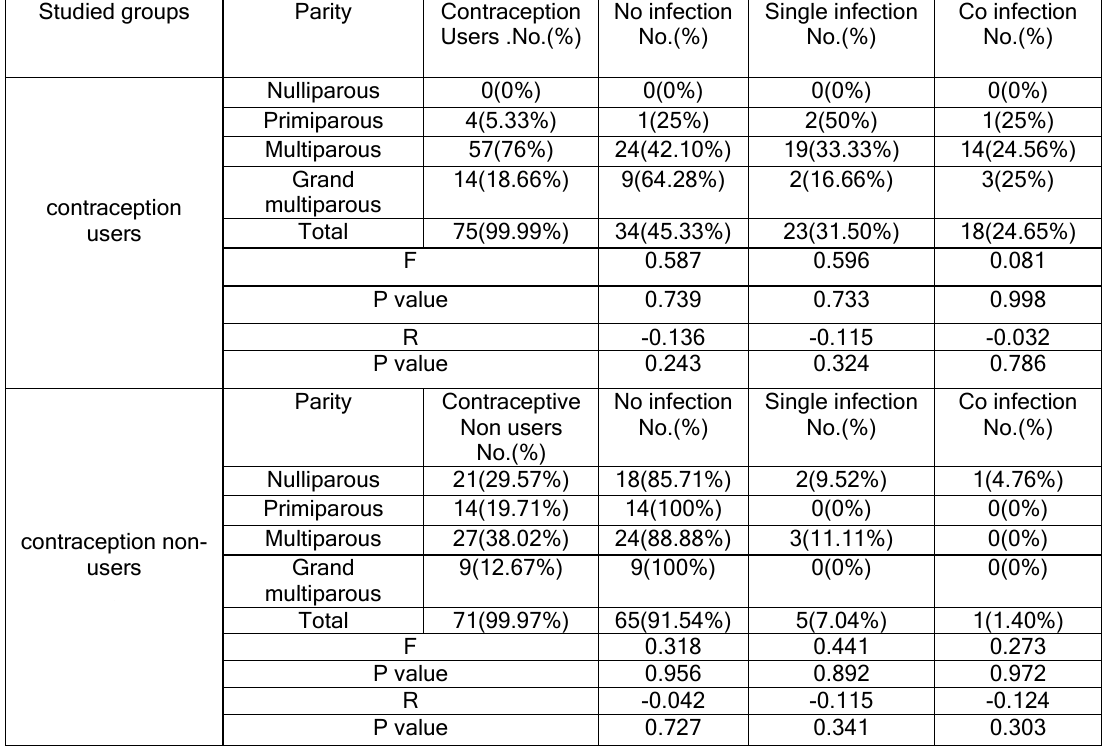
t-Test for Independent or Correlated Samples Table (2): Distribution of studied group according to infection among different parity